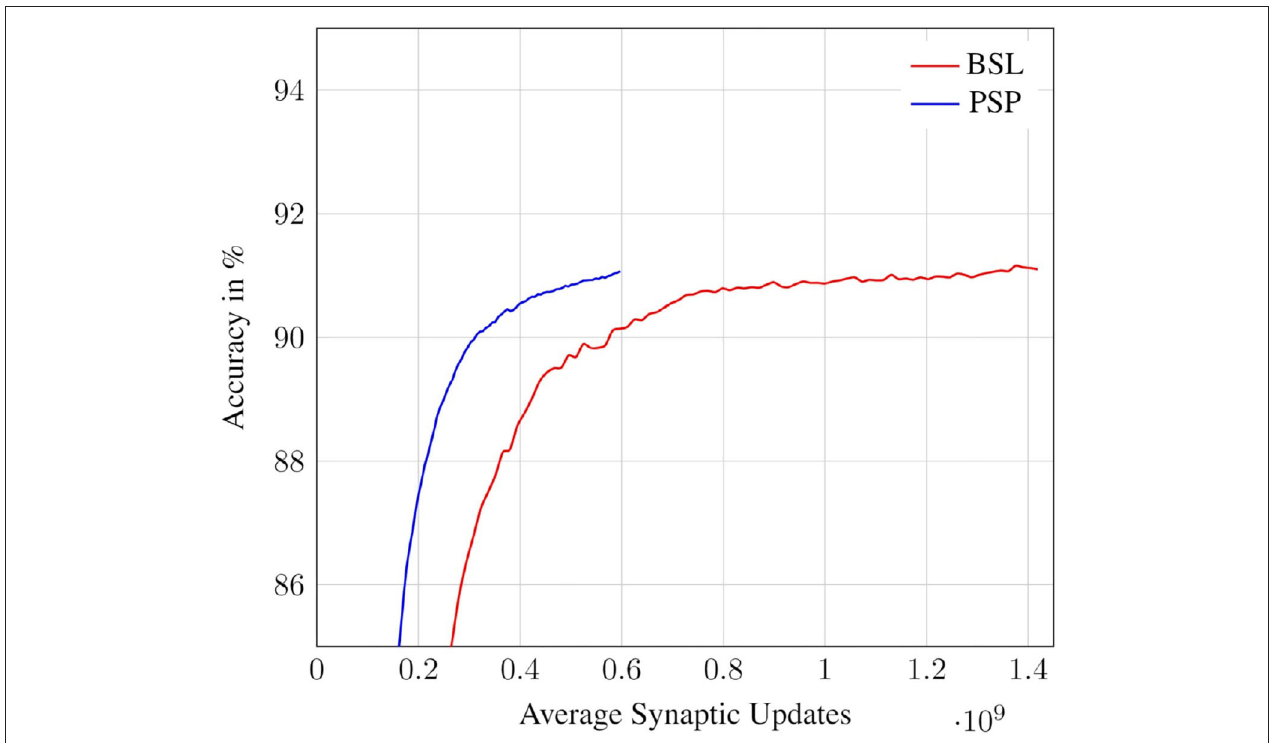
FIGURE 10 | Accuracy vs. Synaptic updates: PSP performance in the CIFAR10-AllConv network.